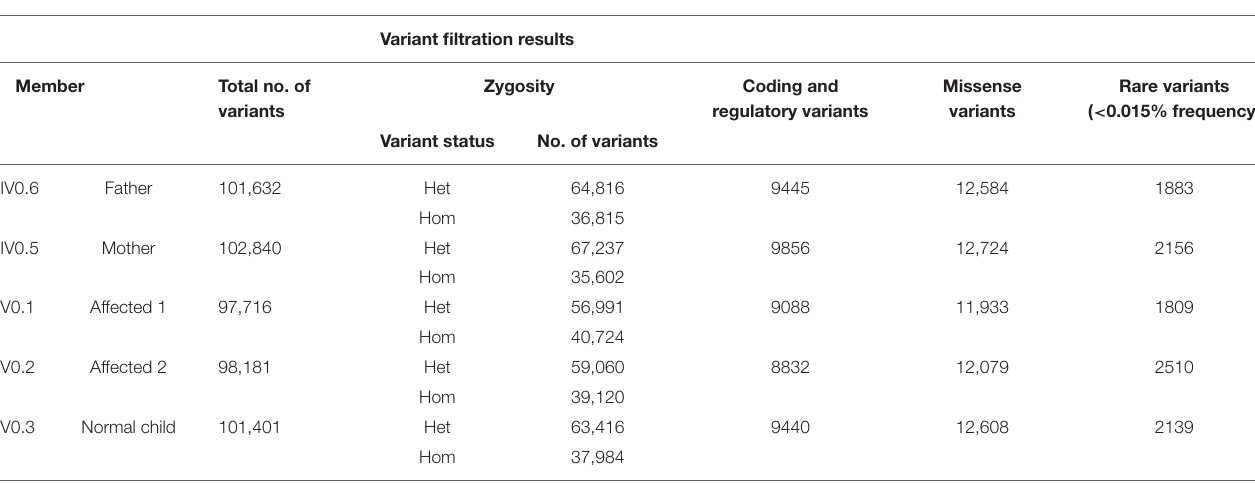
FIGURE 1 | Pedigree of the consanguineous family multiple autoimmune disease. Exome data generated for individuals with an * mark. For PAK2 gene, T is wild-type, and C is the variant allele , TAP2 gene, G is wild-type, and A is the variant allele, and PLCL1 gene, T is wild-type, and A is the variant allele. TABLE 1 | The exome variant yield of the family